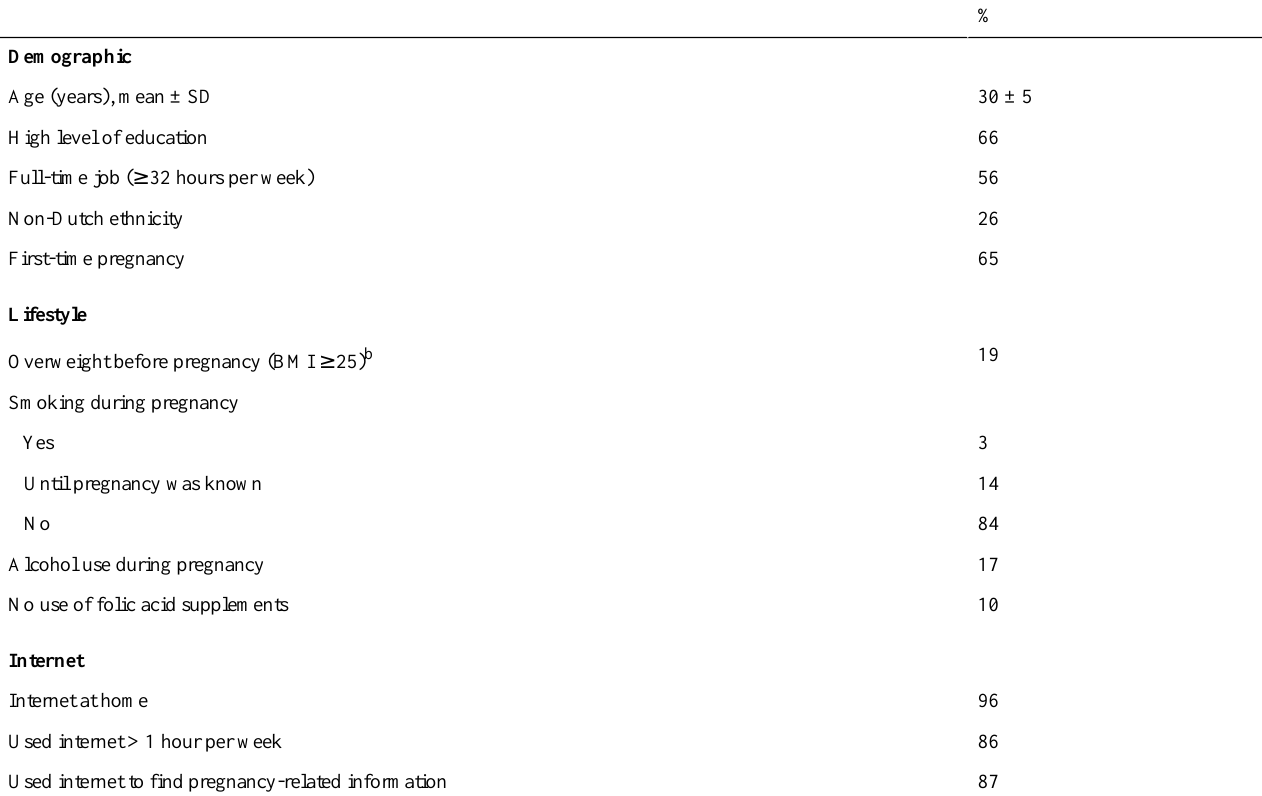
Table 2. Baseline characteristics of participants (n = 343)